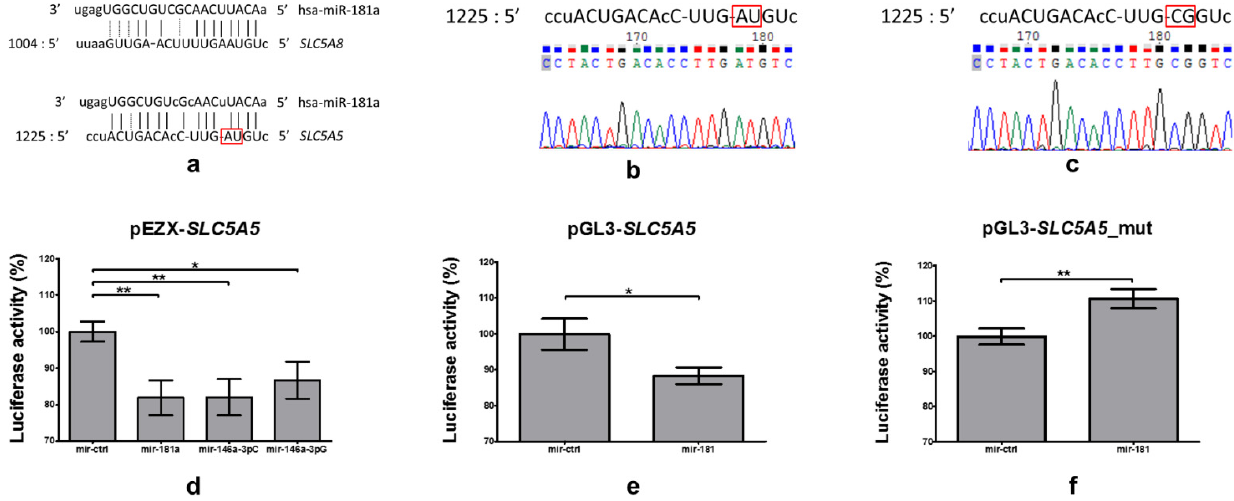
Figure 4. ( a ) In silico analysis revealed similarity between region of 3 ′ UTR of SLC5A8 , which binds with miR-181a-5p (upper part), and region of putative binding of miR-181a-5p in 3 ′ UTR of SLC5A5 (lower part; adapted from microrna.org). ( b ) A 118bp fragment of 3 ′ UTR of SLC5A5 , containing a putative binding site for miR-181a-5p, was subcloned into pGL3- MCS_down_luc plasmid. ( c ) Two nucleotides (1241–1242) were mutated in putative binding site. ( d ) Co-transfection of HeLa cells with pEZX- SLC5A5 and plasmids expressing mir-181a, mir-146a-3pC or mir-146a-3pG resulted in a reduction in luciferase activity by 18 ( p = 0.005), 18 ( p = 0.006) and 13% ( p = 0.033), respectively, in comparison with mir-ctrl. ( e ) Co- transfection of HeLa cells with pGL3- SLC5A5 , containing a 118bp fragment of 3 ′ UTR of SLC5A5 with putative miR-181a-5p binding site, and plasmids expressing mir-181a, led to a 12% ( p = 0.032) decrease in luciferase activity. ( f ) Co-transfection of HeLa cells with pGL3- SLC5A5 _mut, containing a 118bp fragment of 3 ′ UTR of SLC5A5 with mutations in putative miR-181a-5p binding site, and plasmids expressing mir-181a, did not lead to a reduction in luciferase activity—an 11% ( p = 0.0085) increase was observed. Luciferase activity is shown as a percentage relative to the control. The results are normalized by Renilla luciferase and derived from three independent experiments, each performed in triplicates. The graph shows the mean, along with deviations from mean (SEM). Statistical analysis was performed using an unpaired t -test (* p < 0.05, ** p < 0.01).